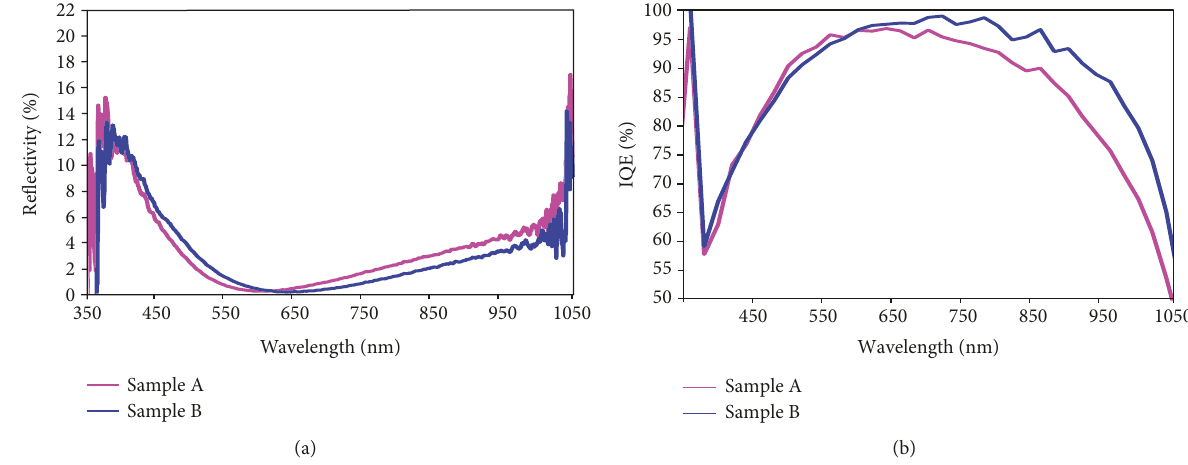
Figure 5: The solar cell data (a) re fl ectance and (b) internal quantum e ffi ciency (IQE) curves. Table 1: Measurement results of the samples of the multicrystalline silicon solar cells.